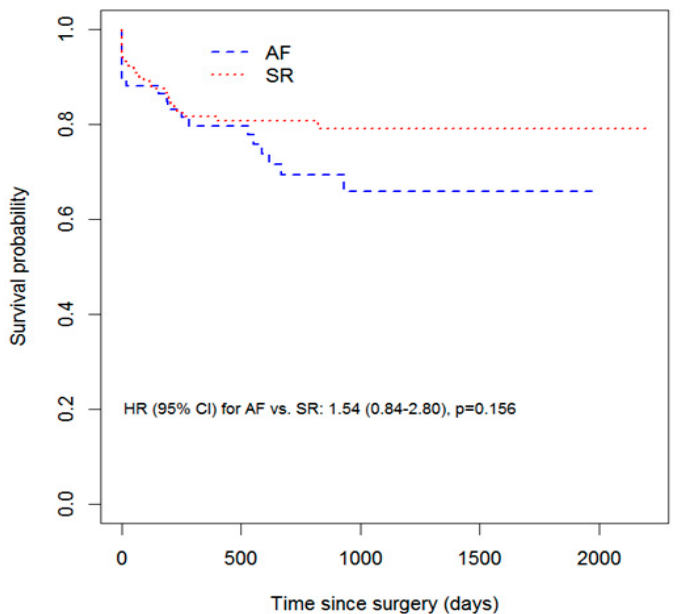
Figure 1. Kaplan–Meier curve for cardiovascular mortality in patients with atrial fibrillation and sinus rhythm.